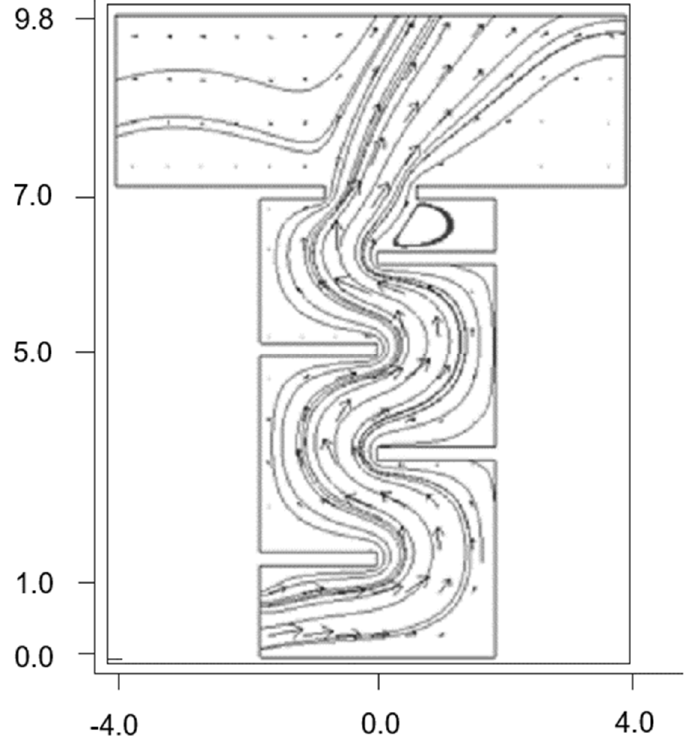
Figure 7. The free convectional airflow (the stack effect) simulation in the space of the staircase (FEMLAB own study). On the x and y axes, the dimensions (in meters) of the staircase are marked.